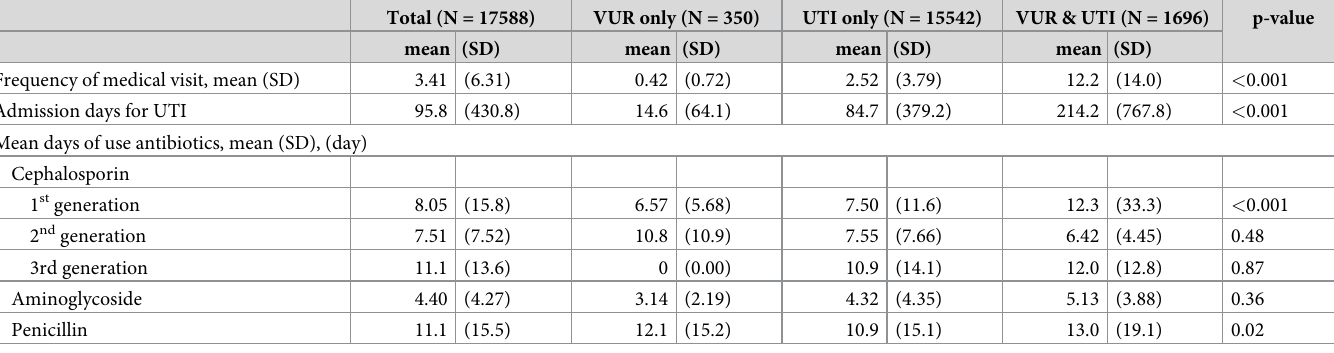
Table 2. Health care and antibiotics utilization among children in 3 study groups: Vesicoureteral reflux (VUR), urinary tract infection (UTI) and VUR &